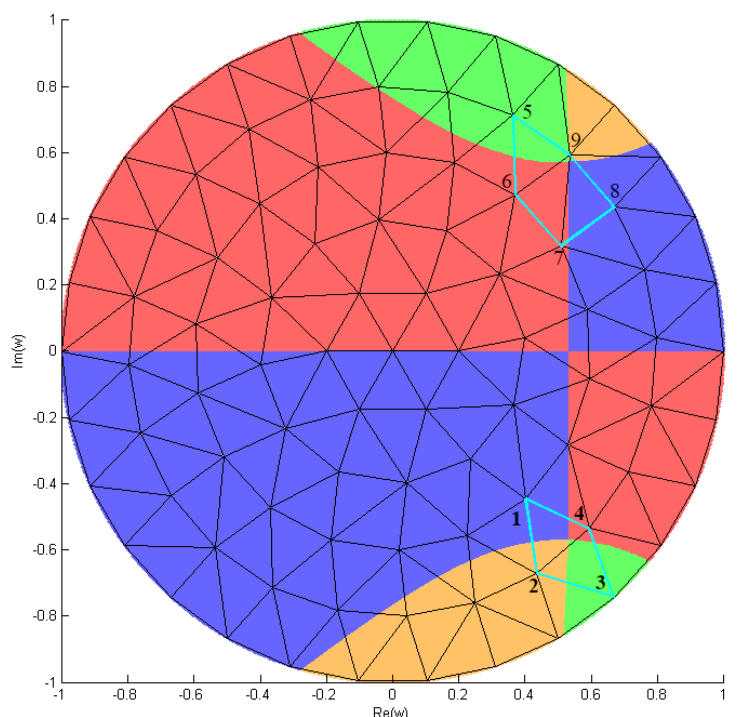
Figure 1. Triangulated area inside the unit circle | w | < 1 for function F ( w ) = ( 1 − w ) 2 α + 0.4 w ( 1 − w ) α + 0.85 w 2 and α = 1.1. Zeros are located at w = 0.53 ± 0.57 j . The candidate edges ( | ∆ Q | = 2) are between nodes 2–4, 6–9, and 7–9. The zeros are located inside contours 1–2–3–4 ( w = 0.53 − 0.57 j ) and 5–6–7–8–9 ( w = 0.53 + 0.57 j ). The boundary of candidate regions consists of cyan lines